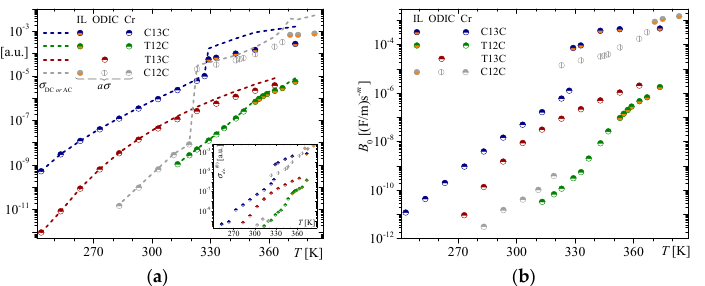
Figure 5. Dependence of ( a ) dielectric conductivity and ( b ) quantity proportional to capacity (describing electrode polarization effect) on temperature for CH-diol isomers in various thermodynamic phases. Insert shows dependence of σ de. on temperature for all CH-diol isomers.